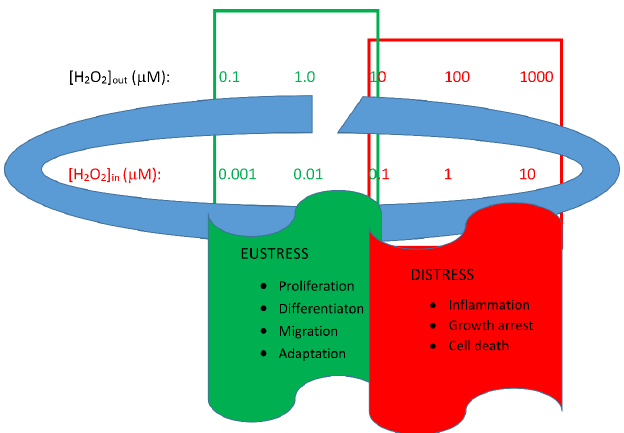
Figure 1. Homeodynamic space. The interpretative model of the regulation of the cellular redox state is based on the existence of a physiological range called the “homeodynamic space”. The rela- tive concentration of H 2 O 2 can determine situations of eustress and distress. In the situation referred to as eustress, the intracellular H 2 O 2 concentration is estimated to be 1–10 nM, while the cytosolic concentration is even lower (around 100 pM). The mitochondrial matrix has a peroxide concentra- tion slightly higher than the cytosolic one (up to 20 nM), thus ensuring a gradient between the or- ganelle and the cytoplasm. In the extracellular space, the H 2 O 2 concentration is between 1 and 5 μM, thus ensuring a gradient of approximately 500 times between the outside and inside of the cell. From Di Filippo et al. [1]